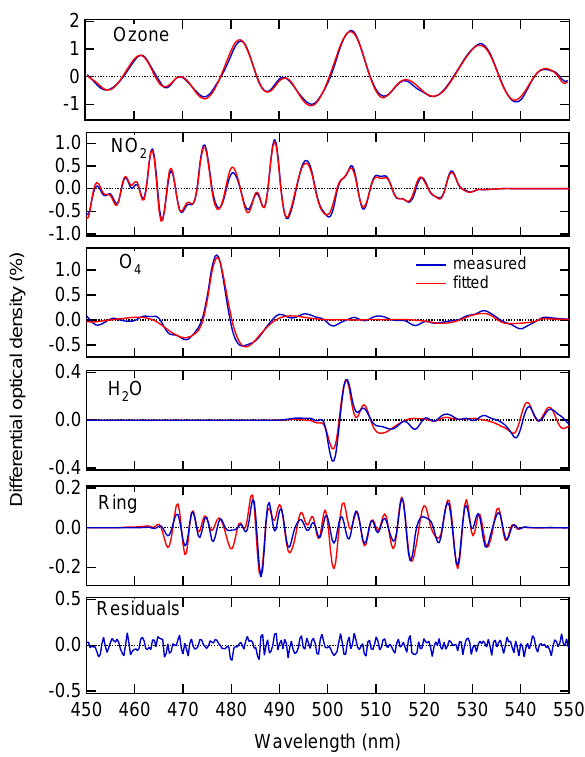
Fig. 2. Typical example of ozone differential slant column fit re- sult, obtained in ScoresbySund, Greenland, on 16 July 2008. The spectrum was recorded at 00:59 UT and 88.0 ◦ SZA. The succes- sive subplots display the respective contributions from O 3 , NO 2 , O 4 , H 2 O and the Ring to the measured and simulated differential optical density. Fitting residuals are shown at the